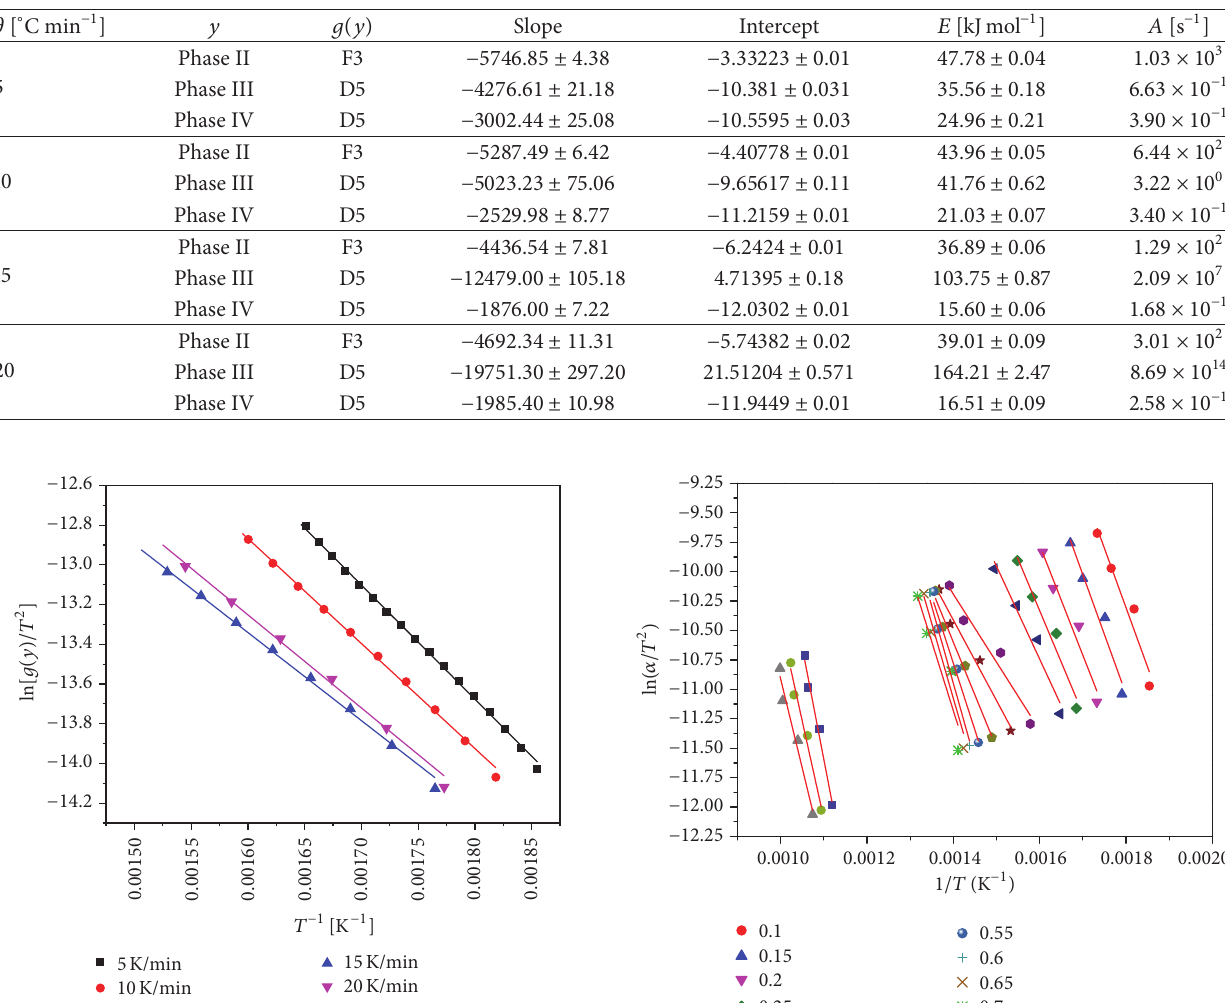
Table 3: Kinetic parameters within different conversion range.